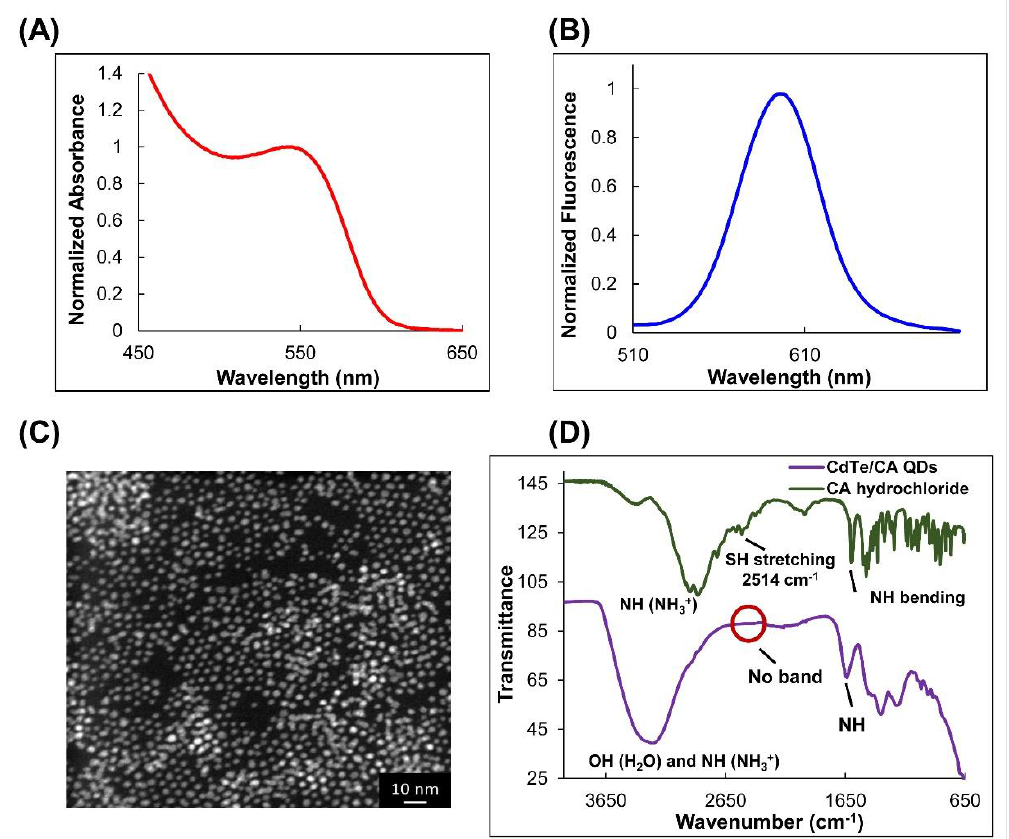
Figure 2. ( A ) Absorption and ( B ) fluorescence emission spectra, ( C ) high-angle annular dark-field (HAADF) image from CdTe / CA QDs, and ( D ) FT-IR spectra of CA hydrochloride (green) and CTe / CA QDs (purple).